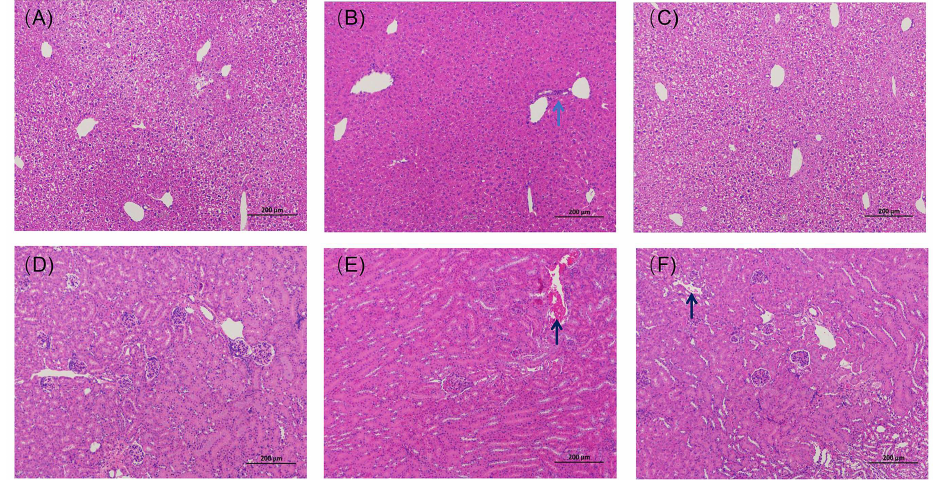
Figure 9. Histopathological studies of the liver and kidney of each group of mice after gavage administration. ( A ) Liver tissue section of the control group; ( B ) liver tissue section of the free GA administration group; ( C ) liver tissue section of the GA-SD administration group; ( D ) kidney tissue section of the normal group; ( E ) kidney tissue section of the GA administration group; ( F ) kidney tissue section of the GA-SD administration group. Scale bar: 200 µm. Black arrows mark cellular debris in the renal tubules; blue arrows mark the phenomenon of inflammatory cell infiltration.